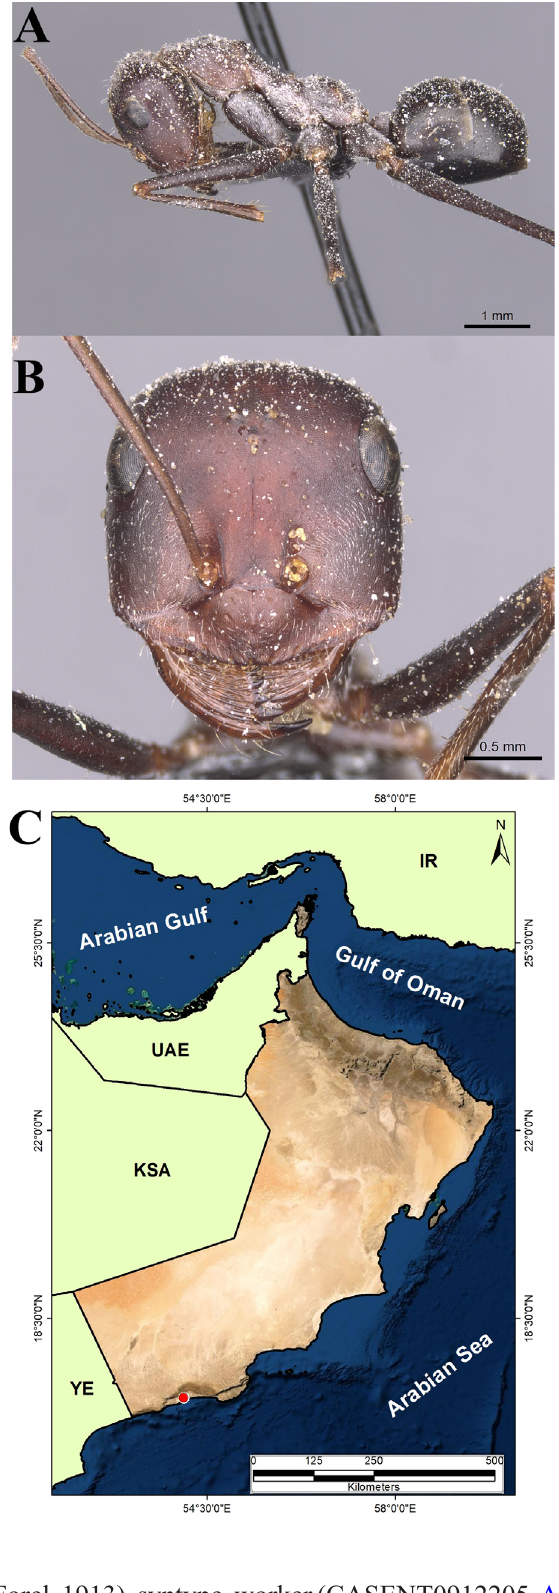
Fig. 11. Cataglyphis isis (Forel, 1913), syntype, worker (CASENT0912205, AntWeb.org (Will Ericson)). A . Body in profile. B . Head in full-face view. C . Distribution